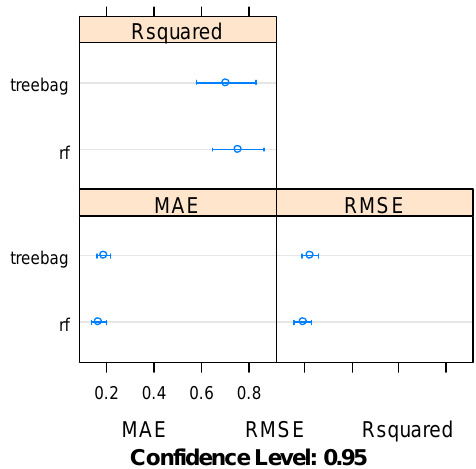
Figure 1. The predictive accuracy of boosting.